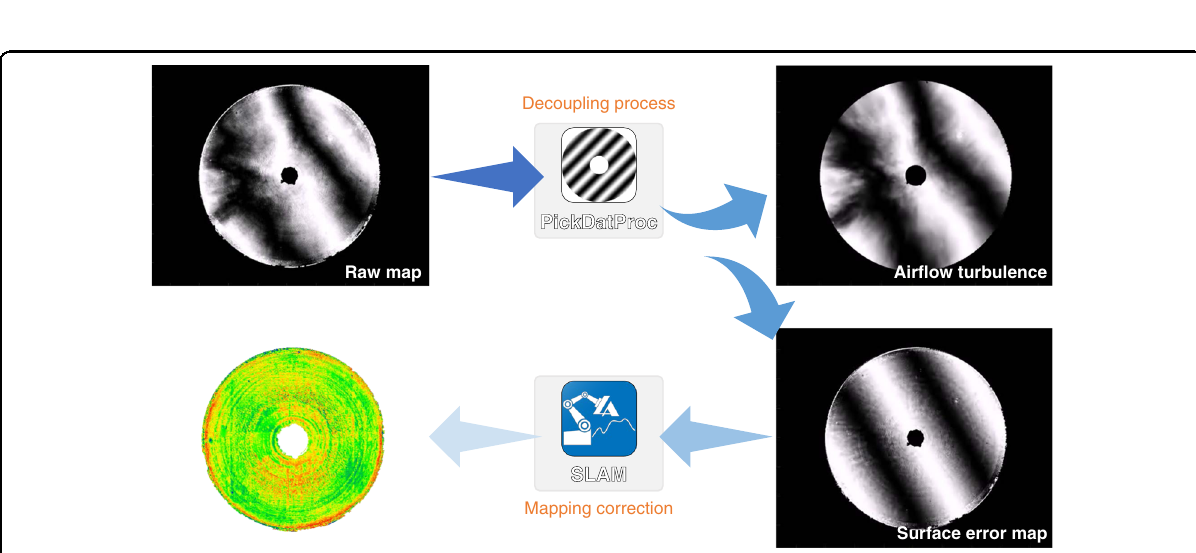
Fig. 18 Subtracting the air turbulence induced error during CGH null test. The decoupling algorithm cancels out the effect of air turbulence on large mirror interferometric null test